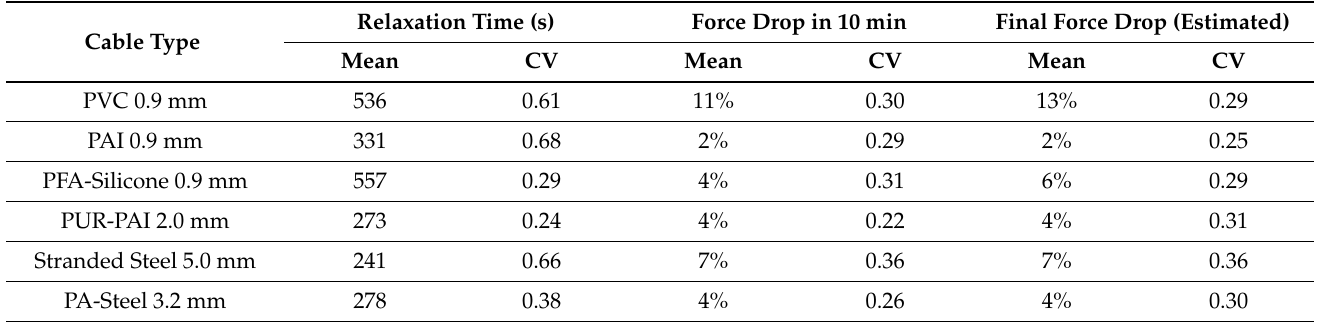
Table 4. Relaxation time and force drop for different types of